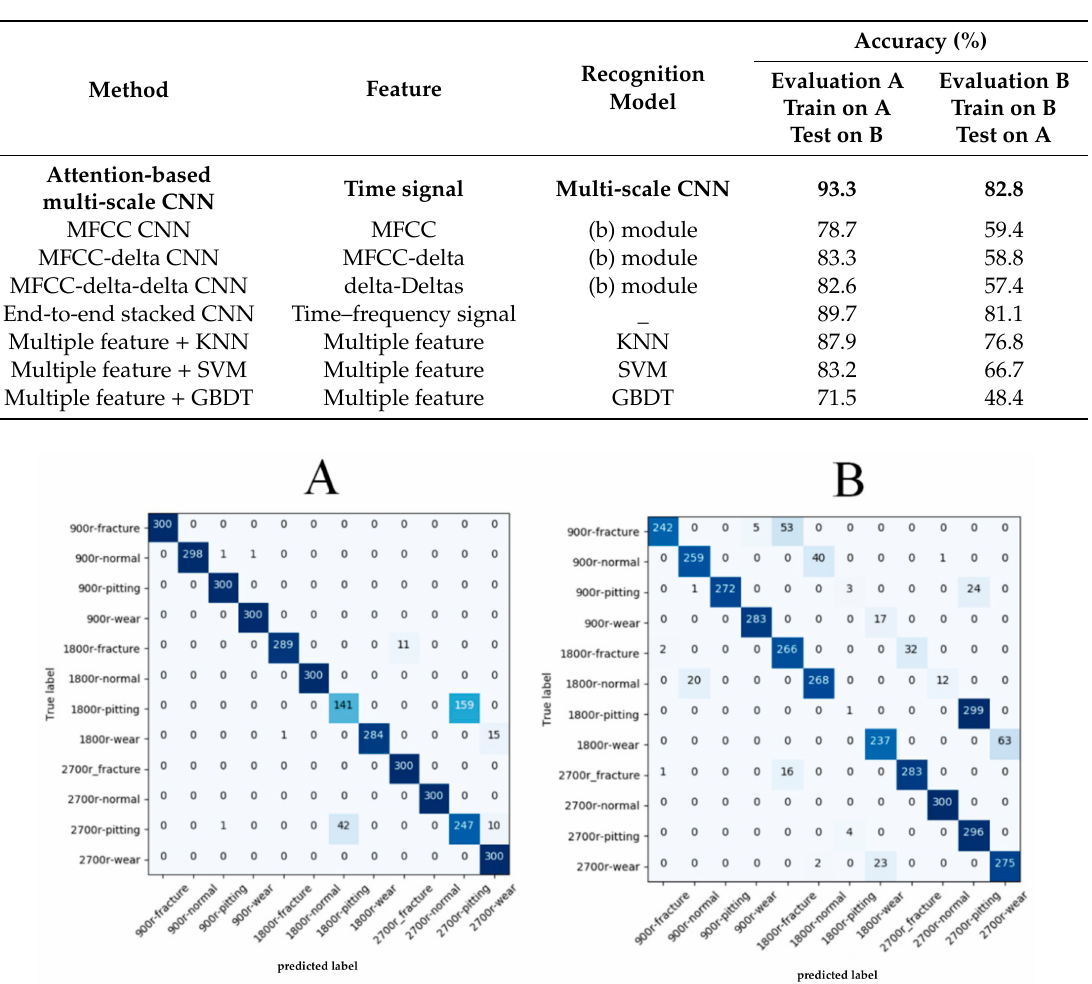
Table 4. Prediction accuracy comparison of our attention-based multi-scale CNN model and other methods. GBDT: Gradient Boosting Decision Tree, KNN: k-nearest neighbor, SVM: support vector machine.